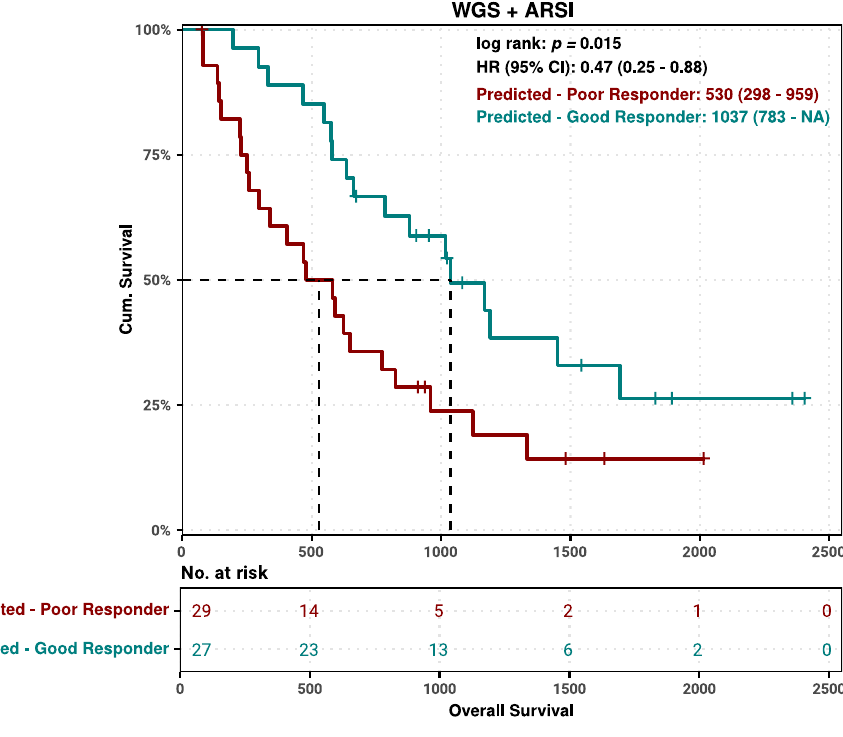
Fig. 7 | External validation of clinicogenomics model in WCDT cohort. Overall survival (OS) of patients in the external WCDT cohort from time of fi rst biopsy to death forpatients withan ARSI asthe next therapyafter biopsy.Patients were sub- grouped based on the clinicogenomics model as predicted good or poor